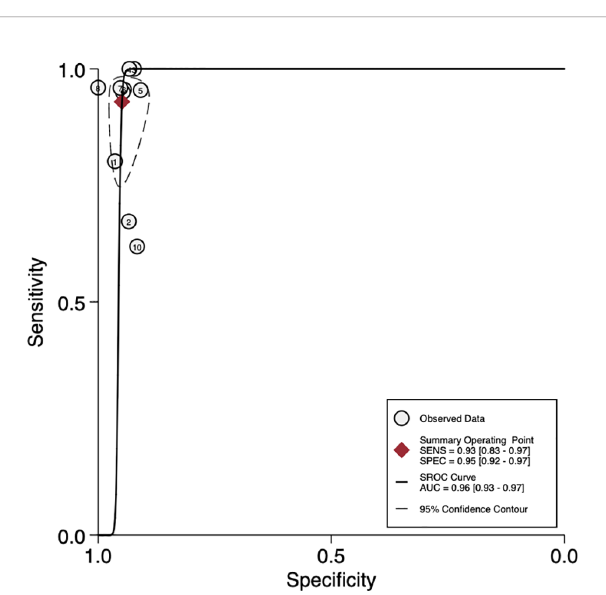
FIGURE 4 | Summary receiver operator characteristic (SROC) curves based on mNGS. AUC, area under the curve; SENS, sensitivity; SPEC, speci fi